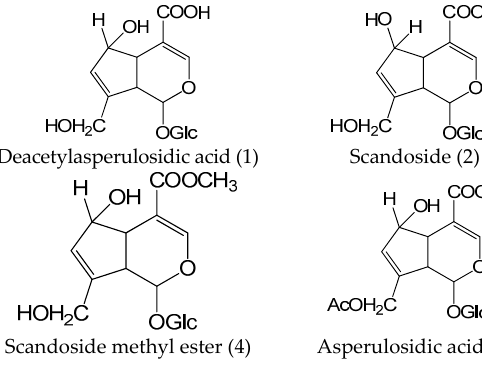
Figure 5. Cont. Figure 5. Cont.